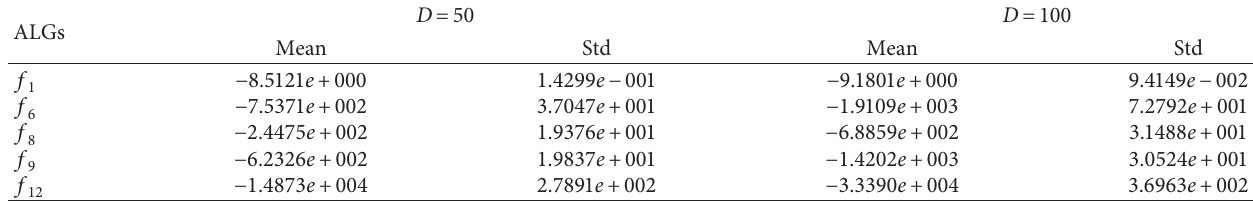
Table 7: Results of the BCSA algorithm combined with the forgetting mechanism when D � 50, 100. D � ALGs